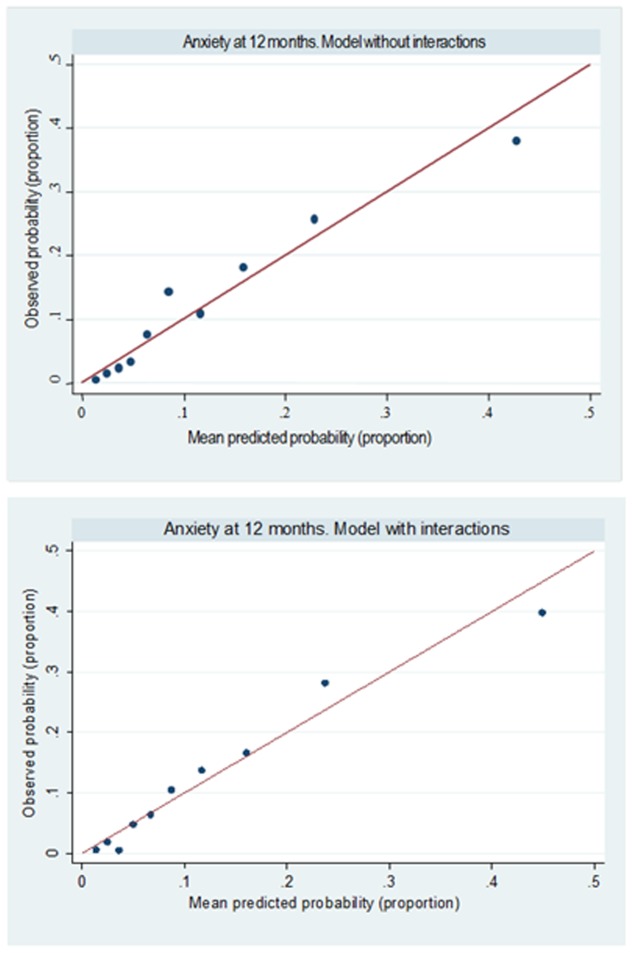
Calibration plots (mean predicted probability versus observed probability of anxiety within deciles of predicted risk) of the predictA-Spain risk algorithm.